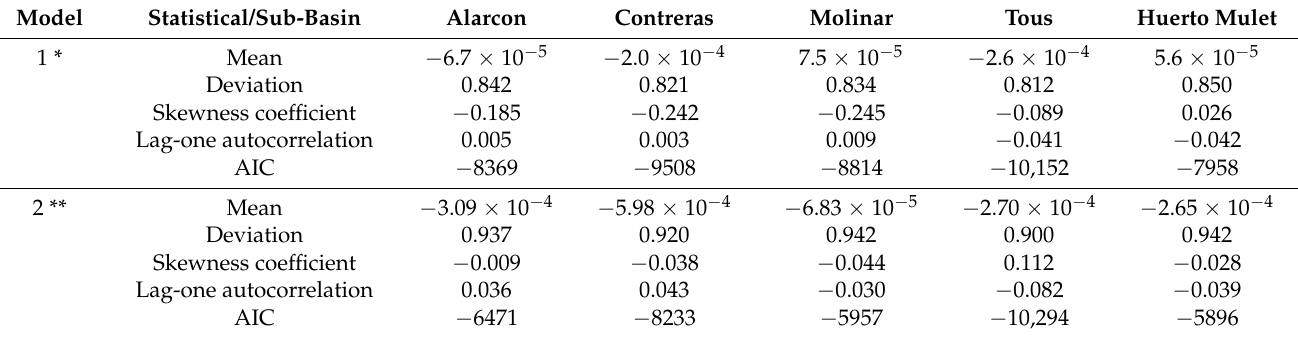
Table 2. Normality analysis for residual series for M1 and M2 (wet threshold